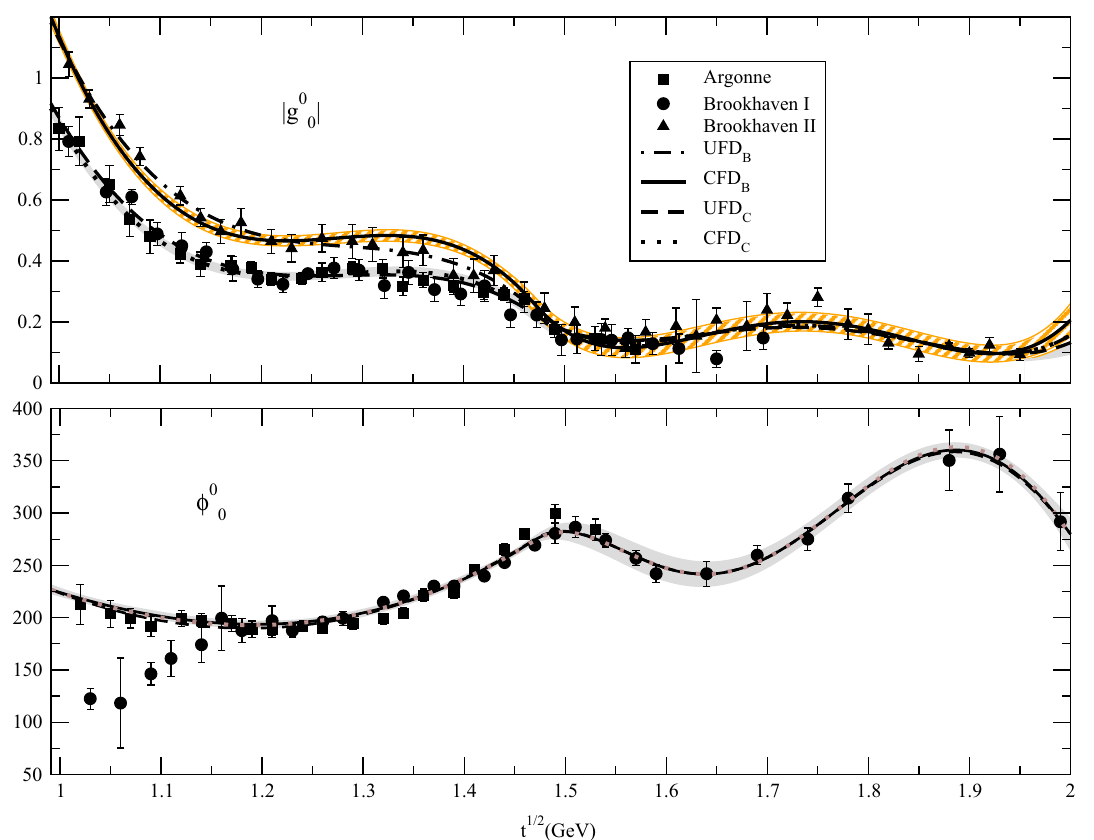
Fig. 15 Comparison between the UFD and CFD parameterizations for ( t ) . The bands cover the uncertainties of the CFD solutions. Upper g 0 0 panel: modulus of the scalar-isoscalar ππ → K ¯ K scattering. The dot- ted line represents the CFD combined fit while the continuous line rep-